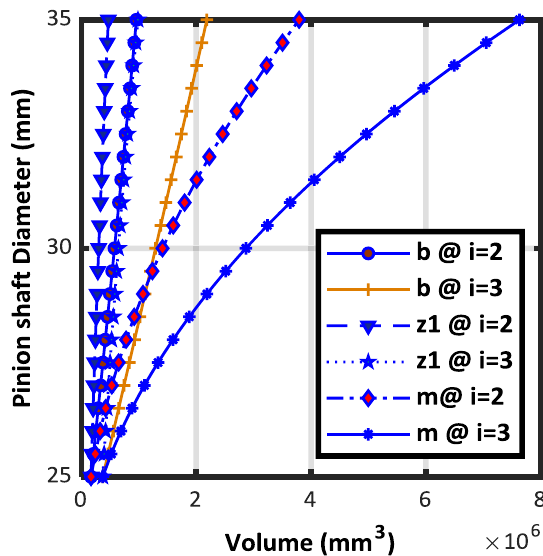
Fig. 13. Volume/pinion shaft diameter